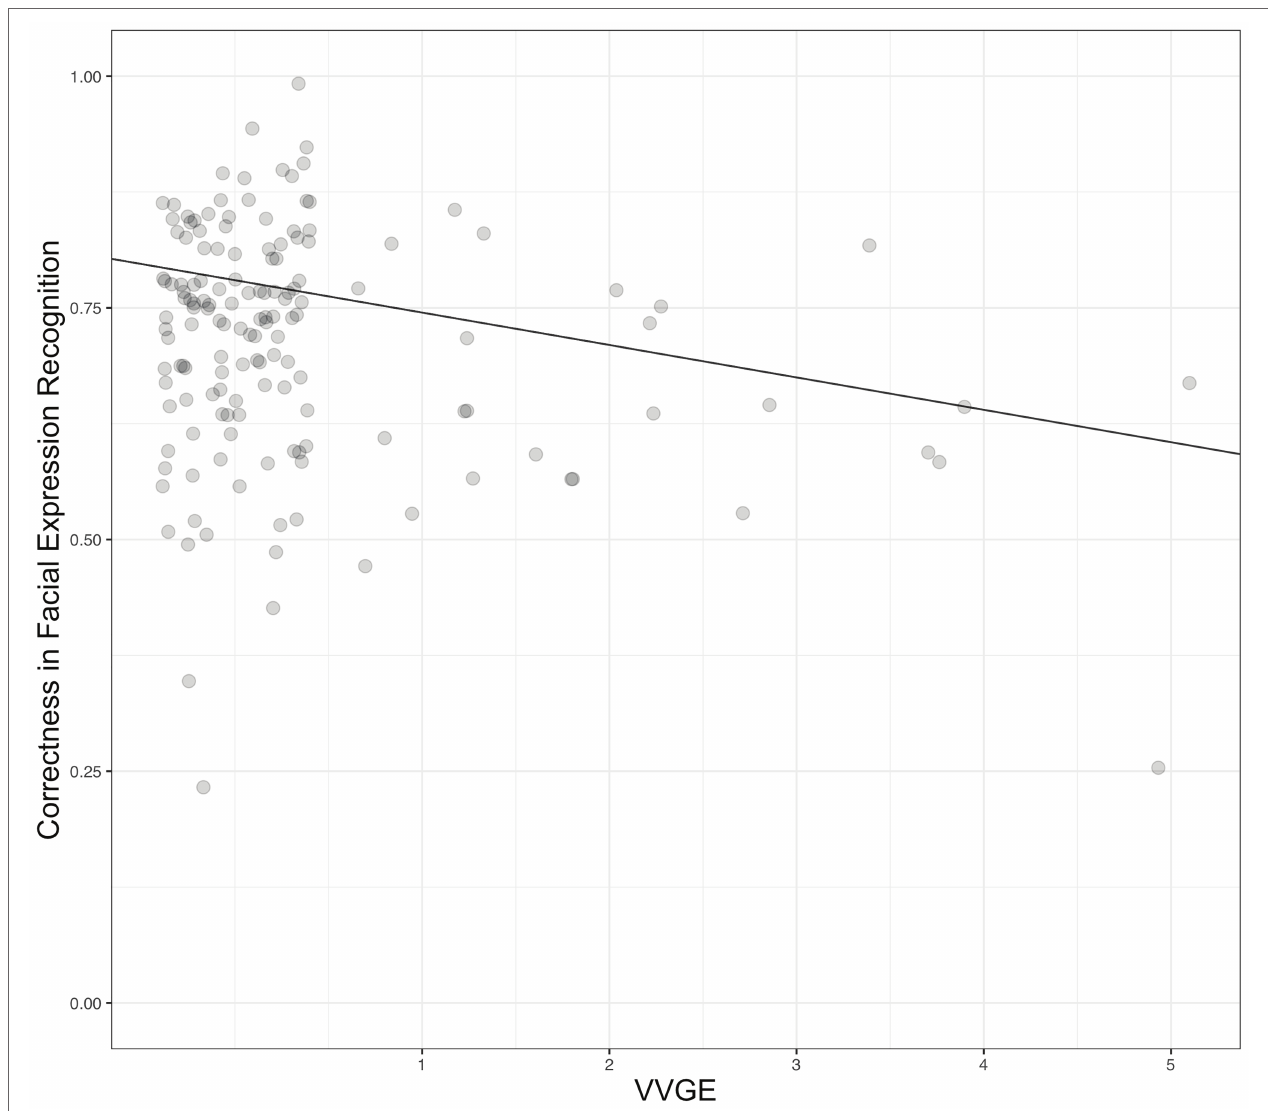
FIGURE 3 | The relationship between VVGE (in hours per day) and correctness in recognition of facial expressions of negative emotions (FEMT; 1.00 = 100% correctness) in Study 2. The value VVGE = 0 represents non-violent gamers or participant who did not play any games, whereas the values VVGE > 0 represent players of violent games, N =